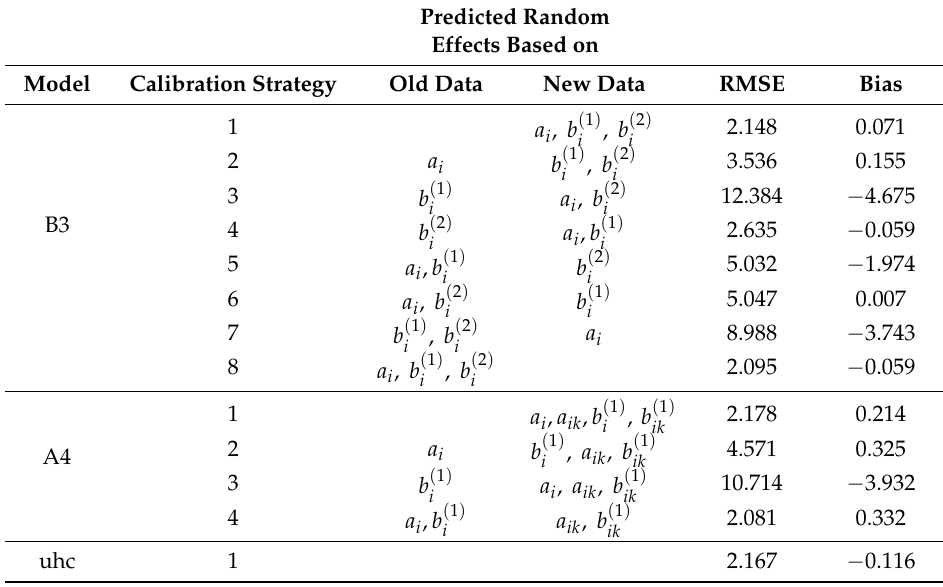
Table 7. RMSE and bias of different calibration strategies compared with the uhc. a i , b are random effects; B3 and A4 are full models of different model types; and uhc is the uniform height